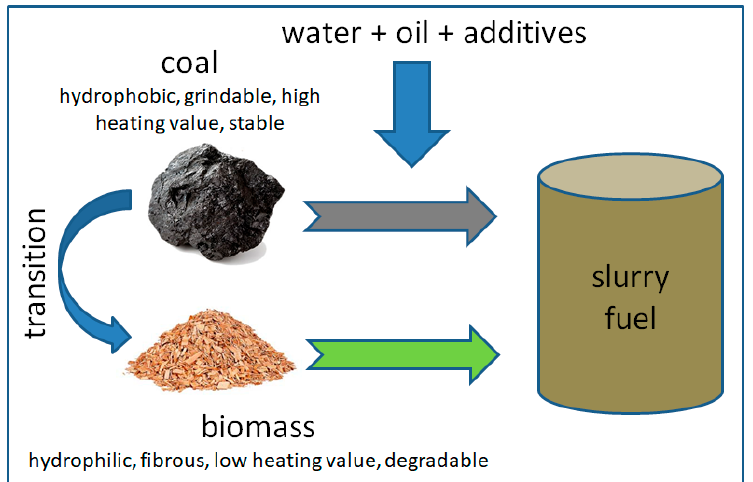
Figure 4. Transition from coal-based to biomass-based slurry fuels.